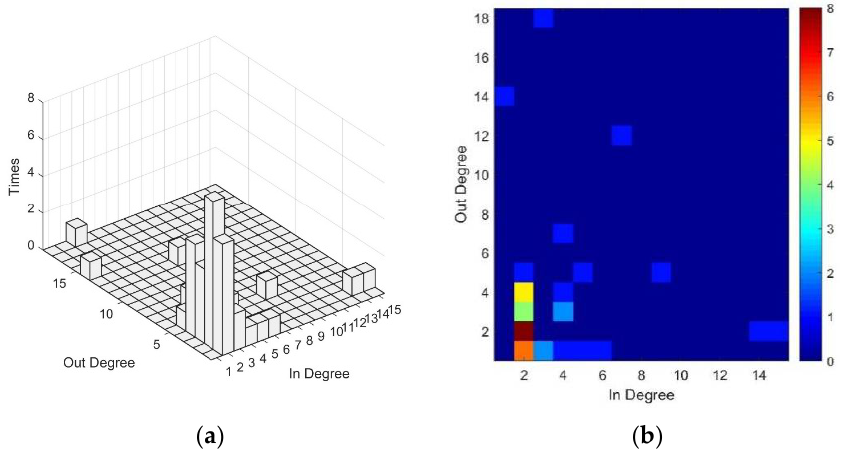
Figure 4. Degree distribution for the developed CN. ( a ) Degree distribution of the CN; ( b ) phase diagram of degree distribution.